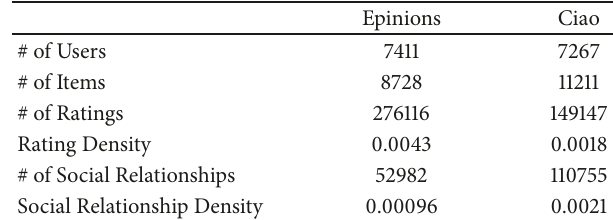
Table 1: Statistics of